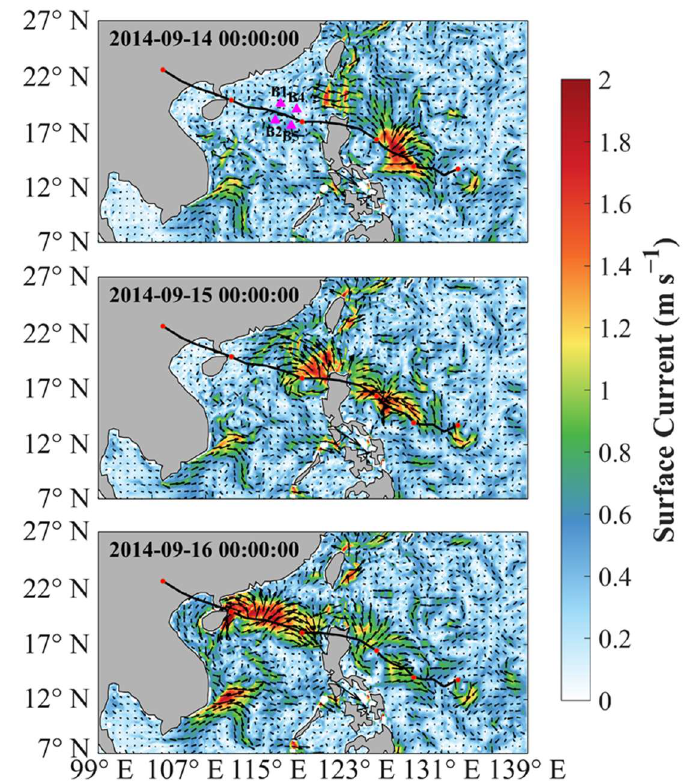
Figure 10. Spatial distribution of sea surface current (m s − 1 ) from the WRS coupled experiment. Vectors show the current direction and the background color represents the current speed. Top to bottom: 00:00 14 September, 00:00 15 September and 00:00 16 September. The black line shows the TC track, the red dots are the TC positions between 12 to 17 September, with 1-day intervals, and the magenta triangles are the positions of the buoys.